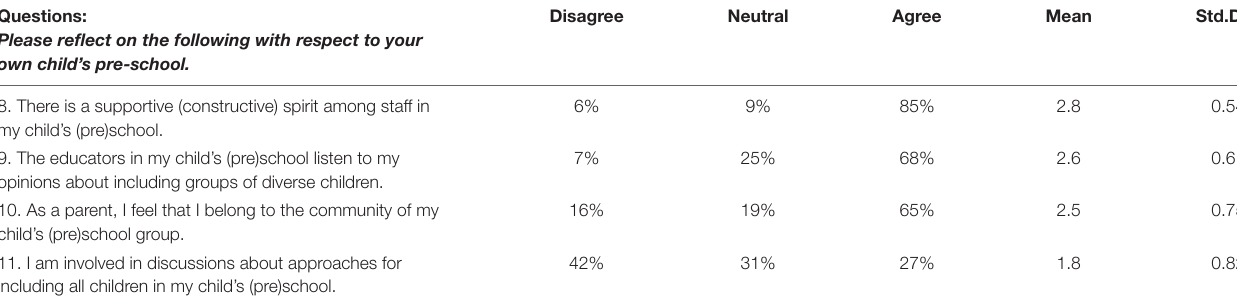
TABLE 8 | Scale 3: Reasons for children to exclude other children. Questions: My child is excluded from the peer group by some children because